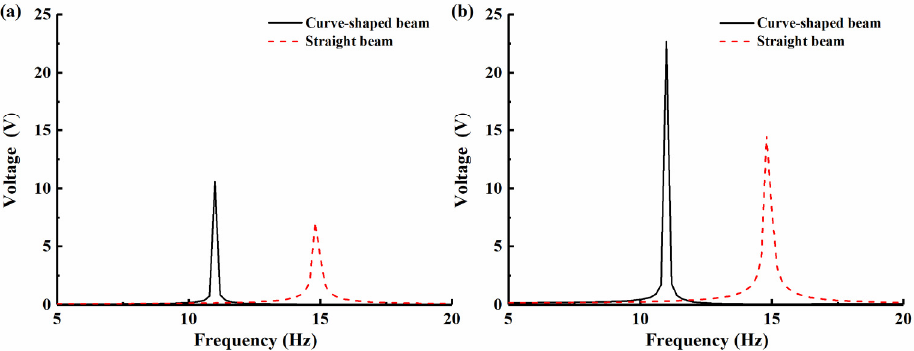
Figure 3. Output voltage obtained by finite-element simulation at different excitation amplitude: ( a ) A = 2 m/s 2 ; ( b ) A = 5 m/s 2 . ( a ) A = 2 m/s 2 ; ( b ) A = 5 m/s 2